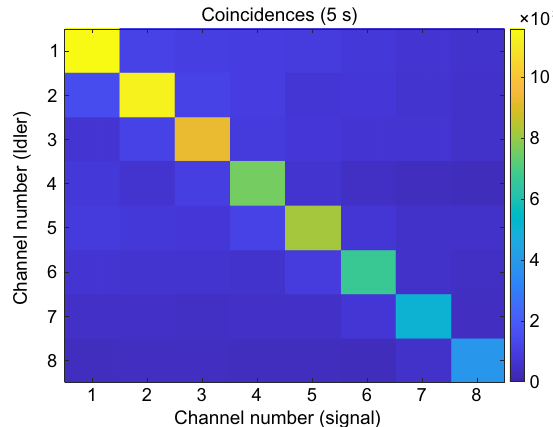
FIG. 2. Joint spectral intensity of the source measured locally with SNSPDs and plotted as a function of the signal and idler channel numbers. Each point is obtained with a 5-ns coincidence window and 5-s integration